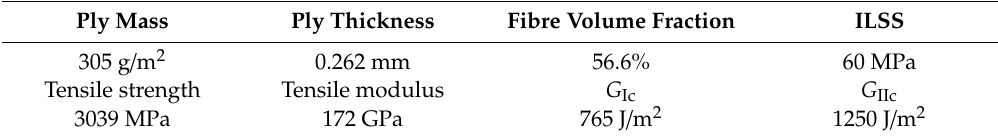
Table 3. M21 resin benefits from toughening low-volume percentage rubber particles with a mean shear interlaminar shear strength.